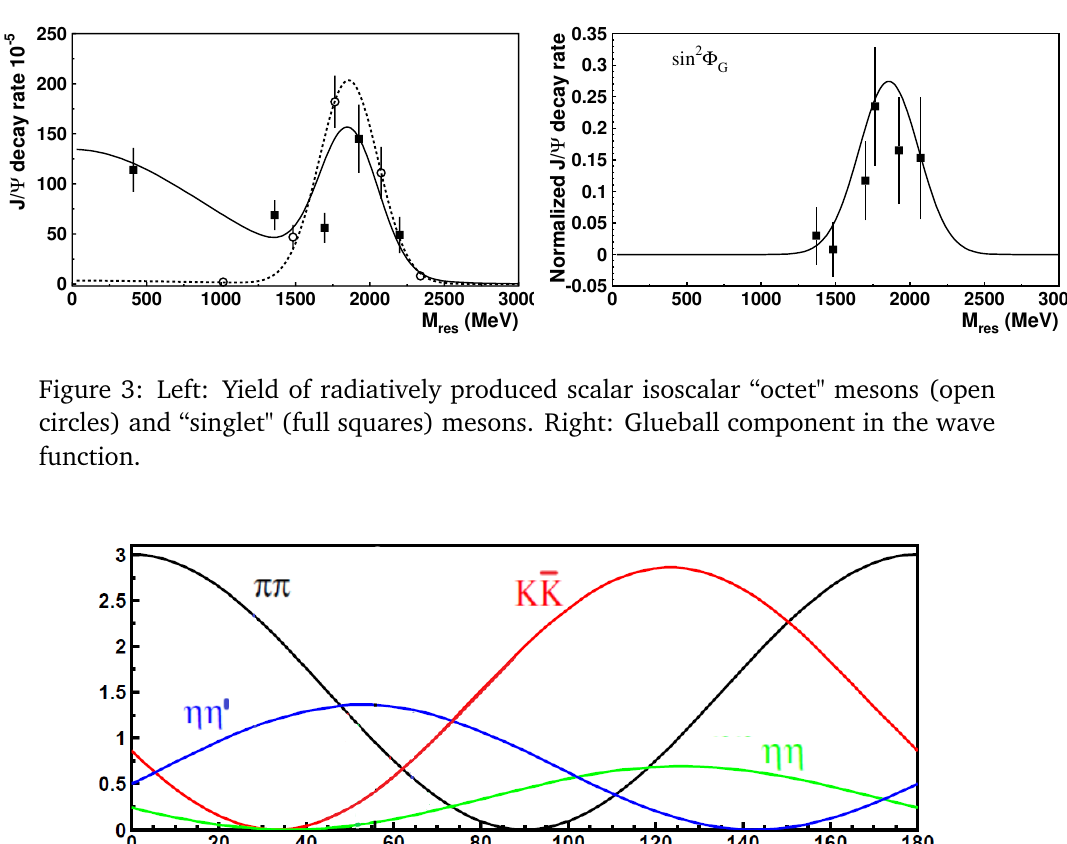
( 1370 ) and f ( 1500 ) : The BESIII data on ππ Figure 2: Left: Interference between f 0 0 and K ¯ K are shown with the BnGa fit (left) and the JPAC fit (right). In the center, the interference of two Breit-Wigner amplitudes with masses and widths given in Table 1 is shown. A phase difference between the ππ and K ¯ K decay modes of 180 ◦ is required to reproduce the phase difference. One state is singlet in SU(3), the other one octet. Right: Squared masses of mainly-octet and mainly-singlet scalar isoscalar mesons as functions of a consecutive number.